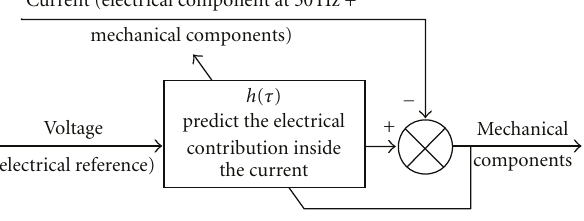
Figure 13: Our Wiener filter